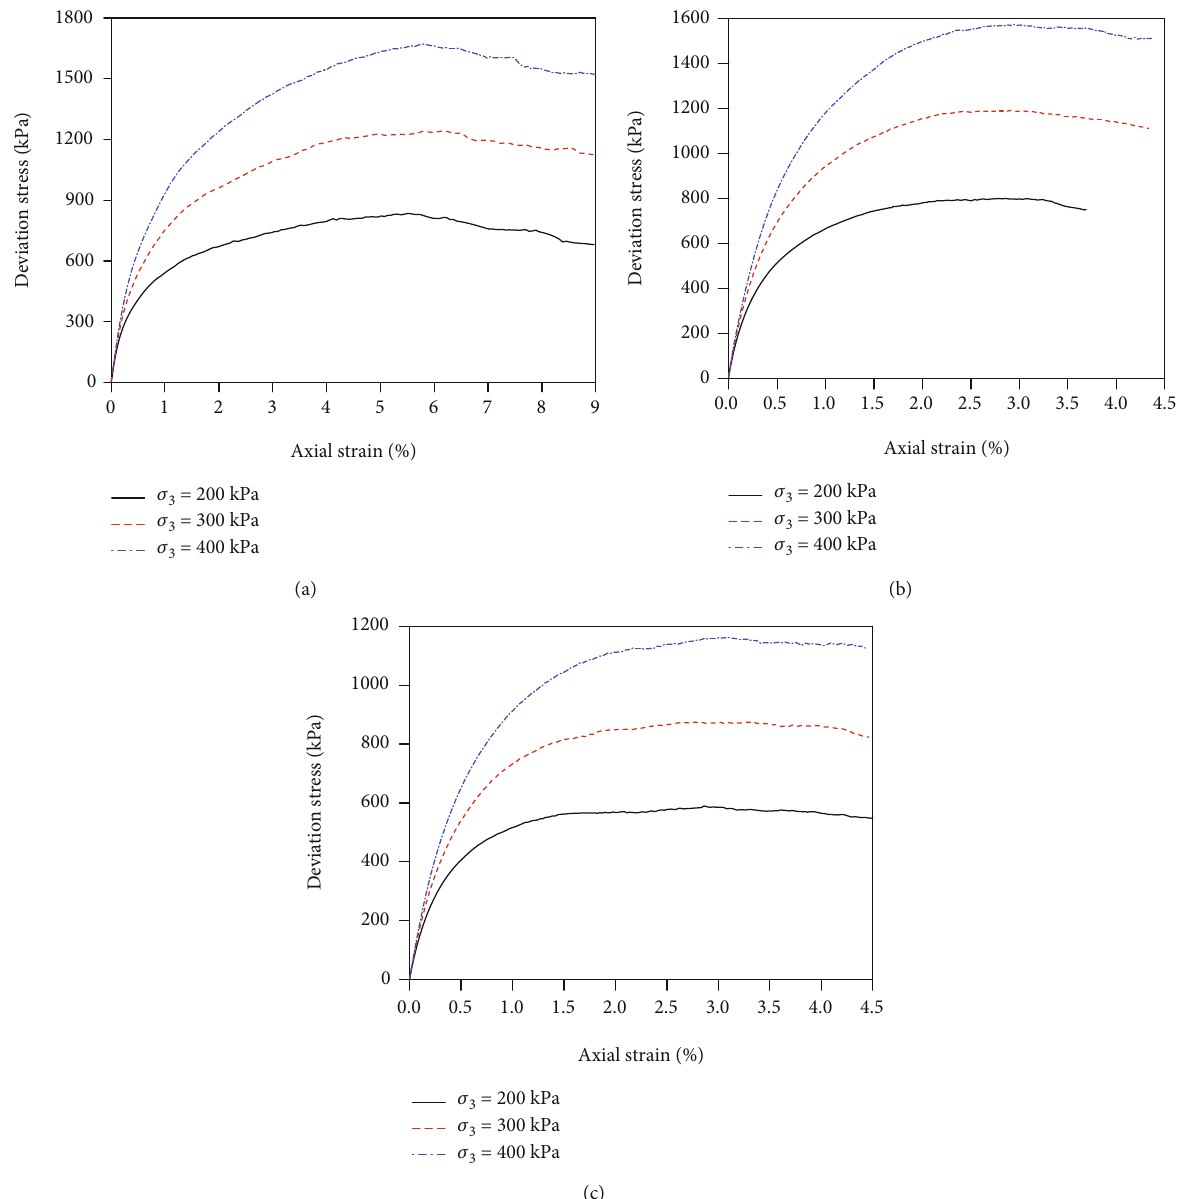
Figure 5: Deviation stress-axial strain curve of triaxial test: (a) non-spherical particles with gradation (working condition I); (b) spherical particles with gradation (working condition II); and (c) non-spherical particles without gradation (working condition